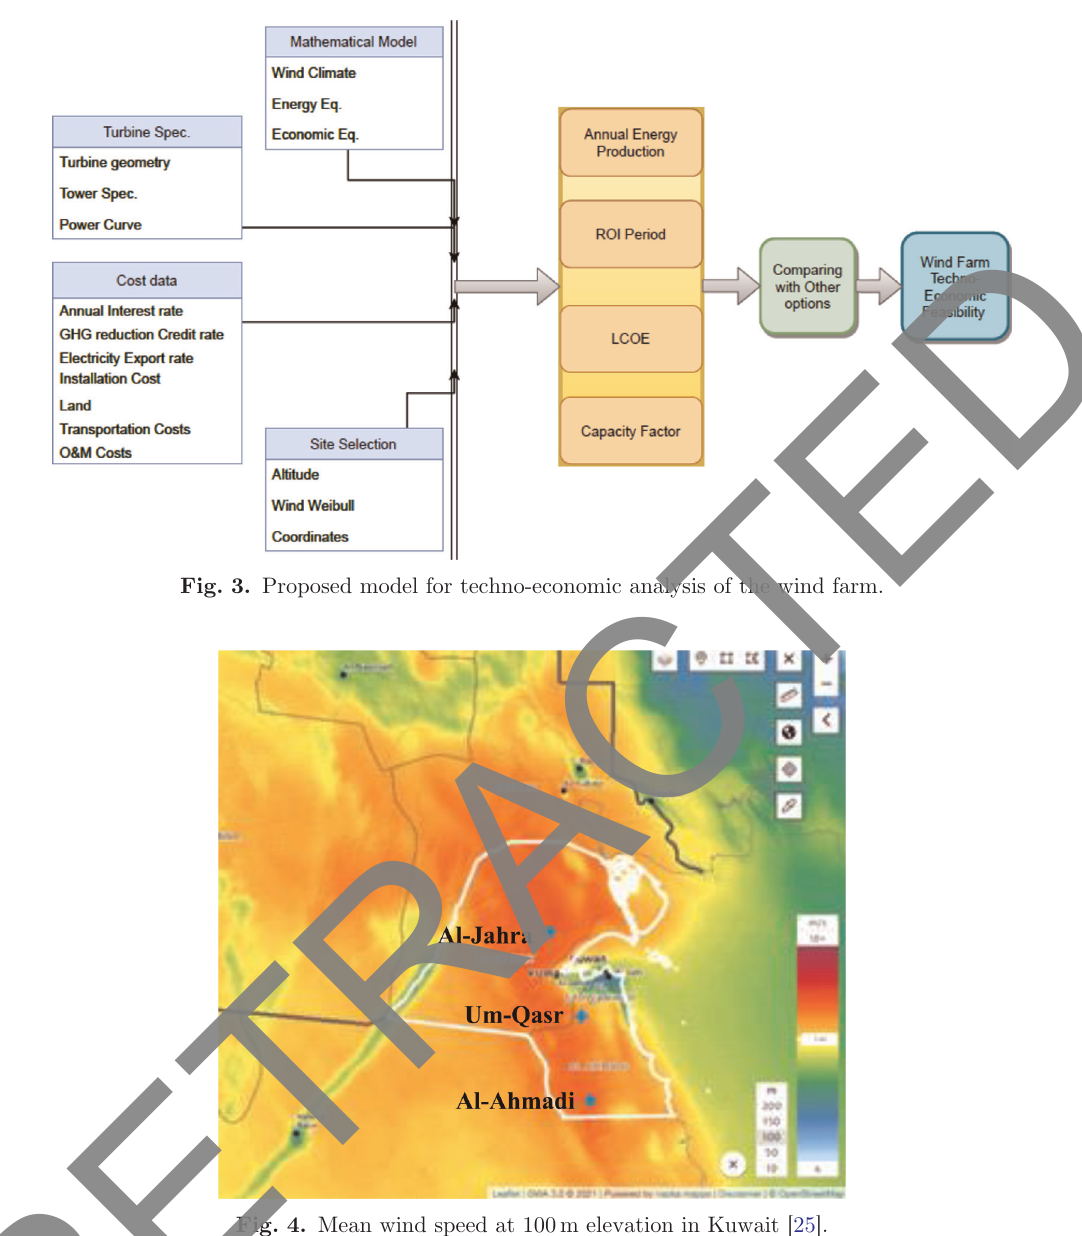
Fig. 4. Mean wind speed at 100 m elevation in Kuwait